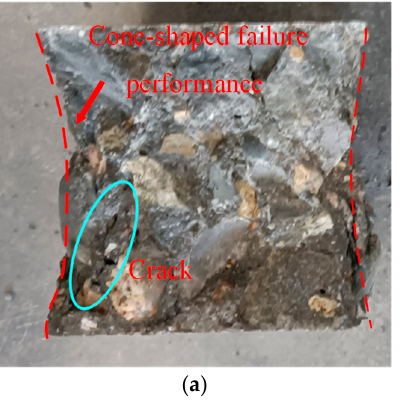
Figure 12. Failure performances of SWSSC specimens after the cube compressive test: ( a ) NF; ( b ) POM-0.6.